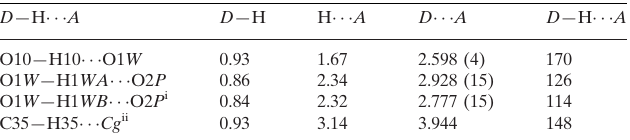
Hydrogen-bond geometry (A˚ , (cid:3) ). Cg is the centroid of the C11–C16